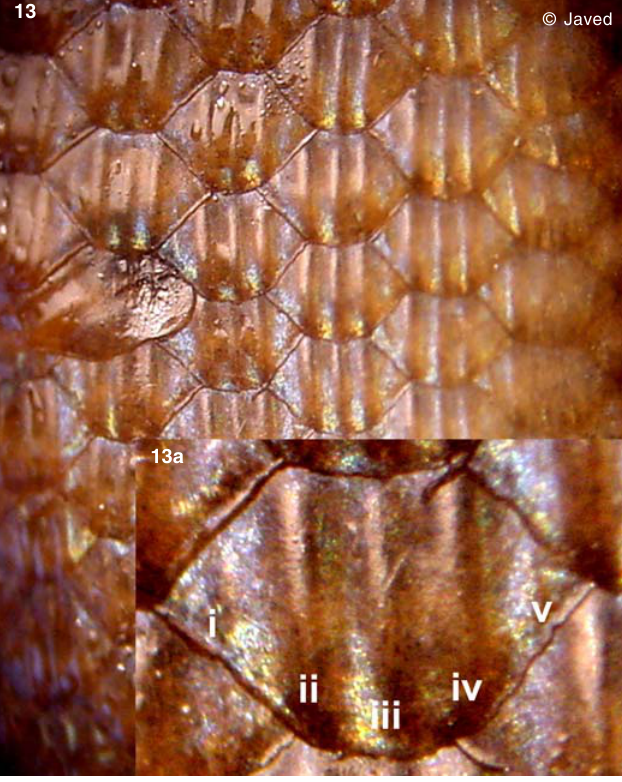
Images 13 (with inset 13a). Eutropis innotata. Dorsal aspect of trunk showing scales with 5 feeble keels (feeble quinquecarinate) and inset showing close up of keels (see numbering).